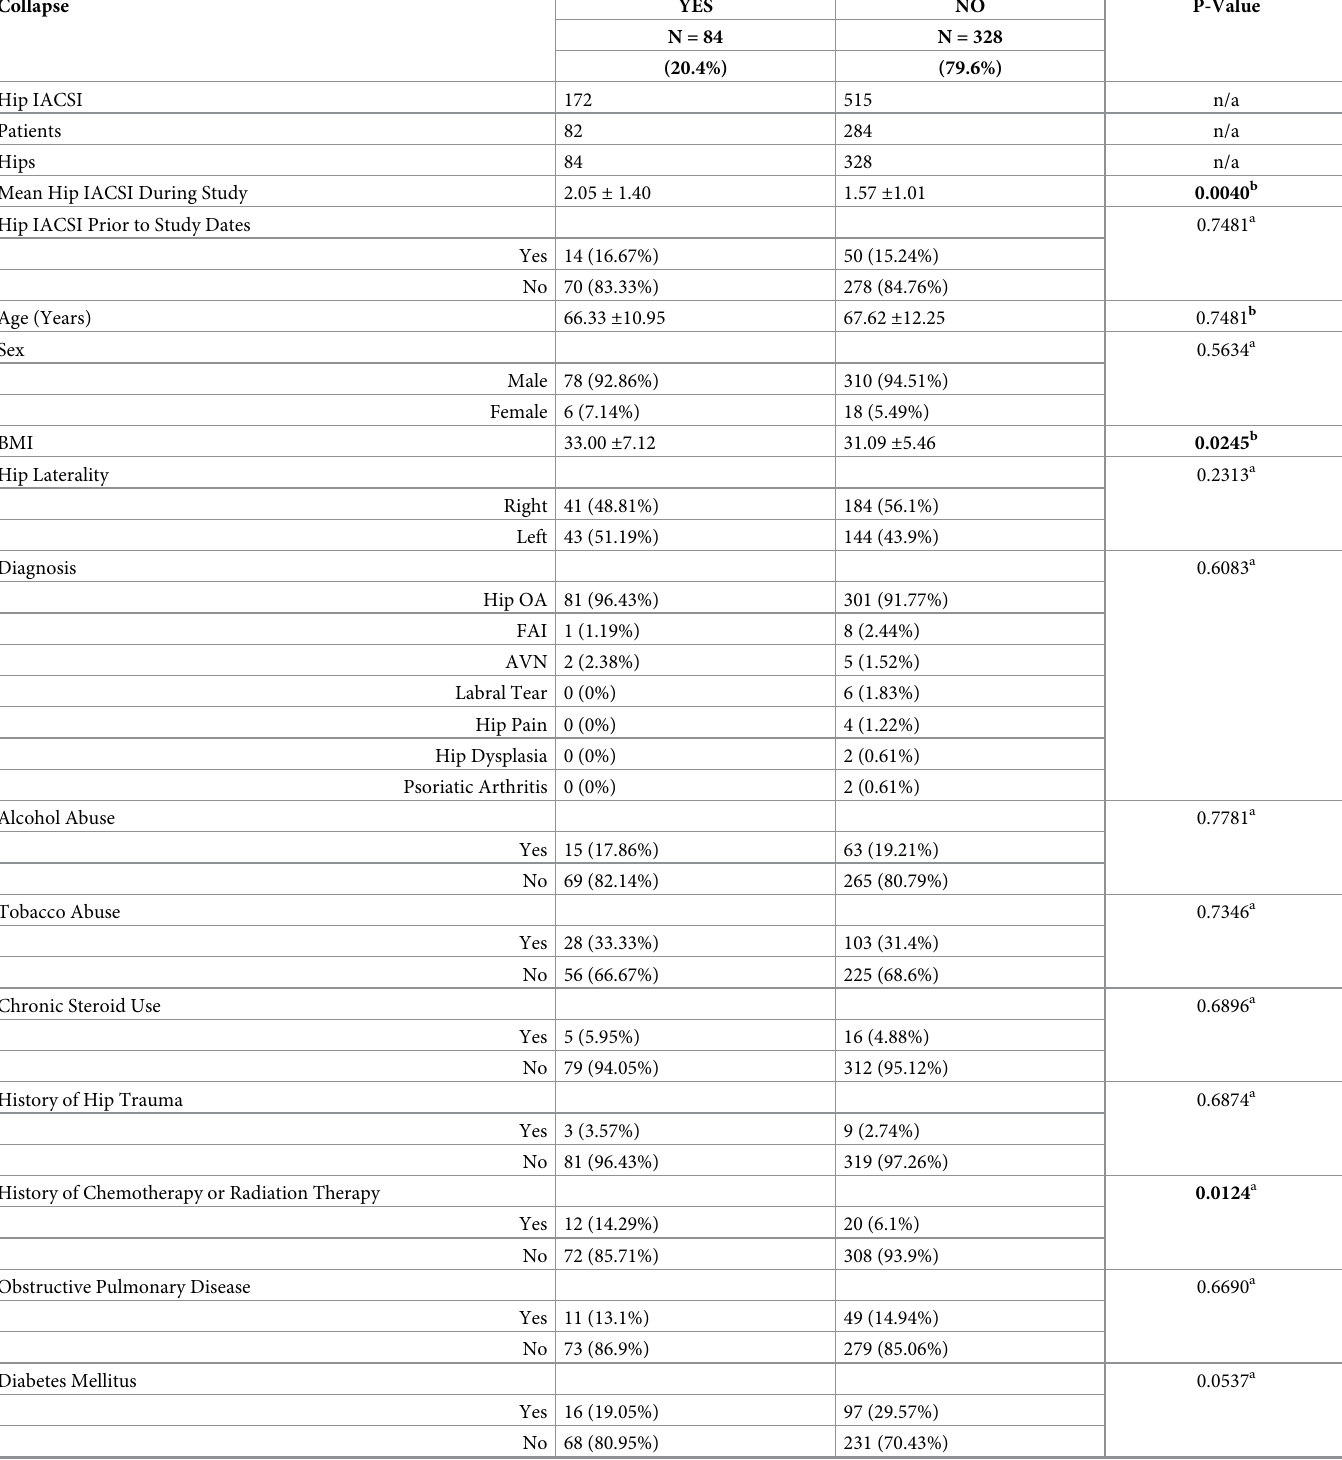
Table 2. Comparison of patient demographics and medical profiles: FHC vs. no FHC after hip